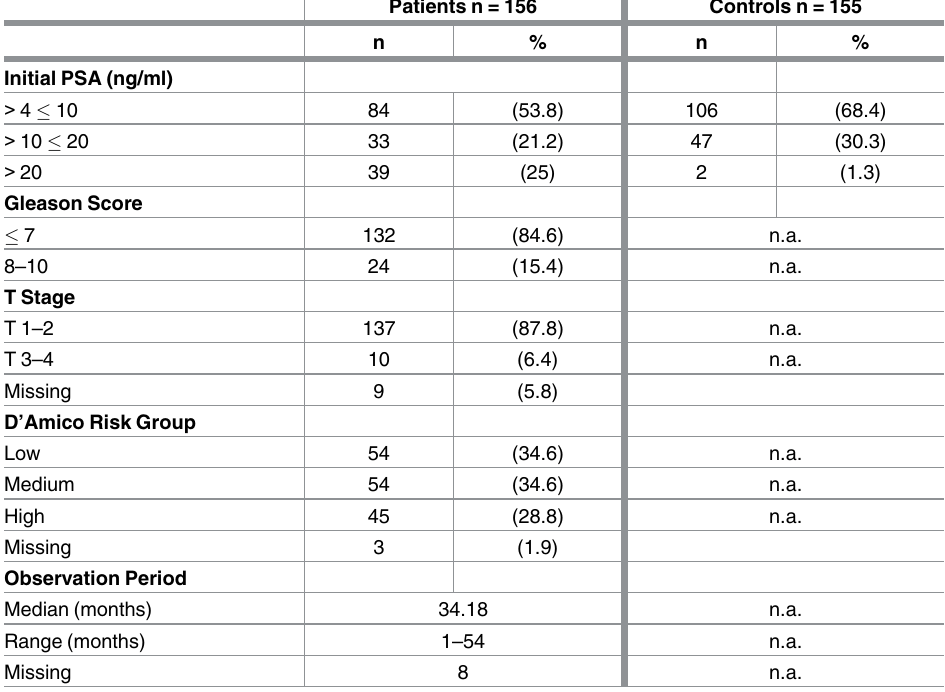
Table 1. Summary of clinical